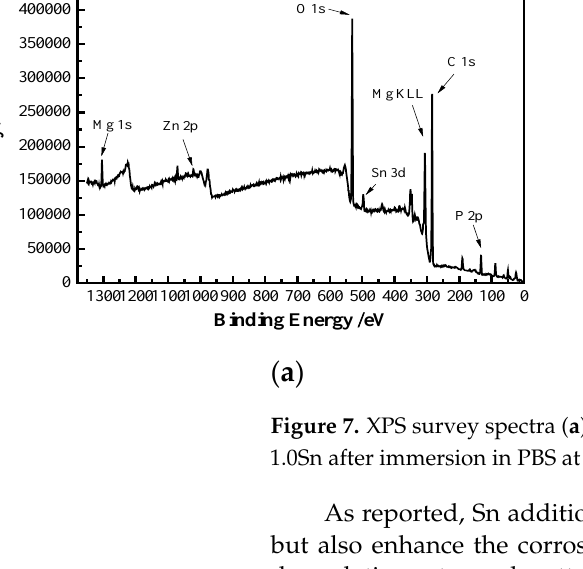
Figure 6. XRD patterns of the corroded alloys with corrosion products.